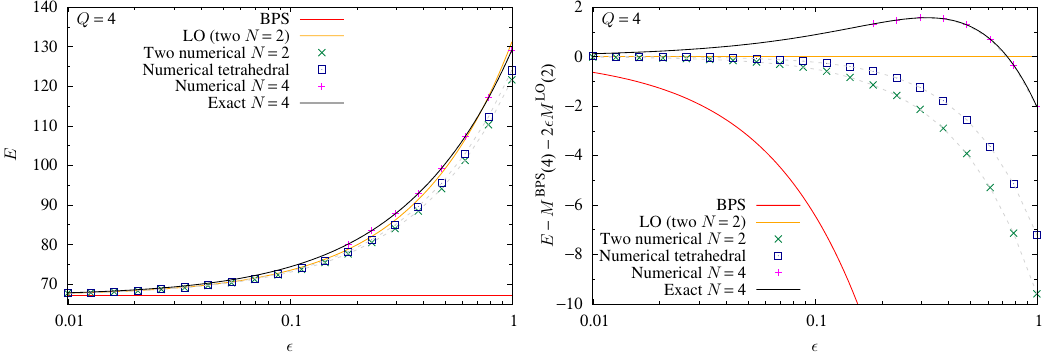
Figure 9 . The total energies of the baby-Skyrmion solutions in the Q = 4 sector. The red line is the BPS bound, the orange curve the LO correction (coming from the kinetic term) for two N = 2 Skyrmions. The numerical solutions are: the two N = 2 Skyrmions side-by-side (green xs), the tetrahedral Skyrmion (blue squares with a dot in the middle), and the axially symmetric N = 4 Skyrmion (magenta pluses). Finally, the latter numerical N = 4 solution is compared to the exact solution (using the 1-dimensional ODE). For clarity, the right-hand side panel shows the same data relative to the orange line, being the LO correction. At (cid:15) . 0 . 15 the axially symmetric soliton becomes unstable and decays to the tetrahedral one — which is only metastable.